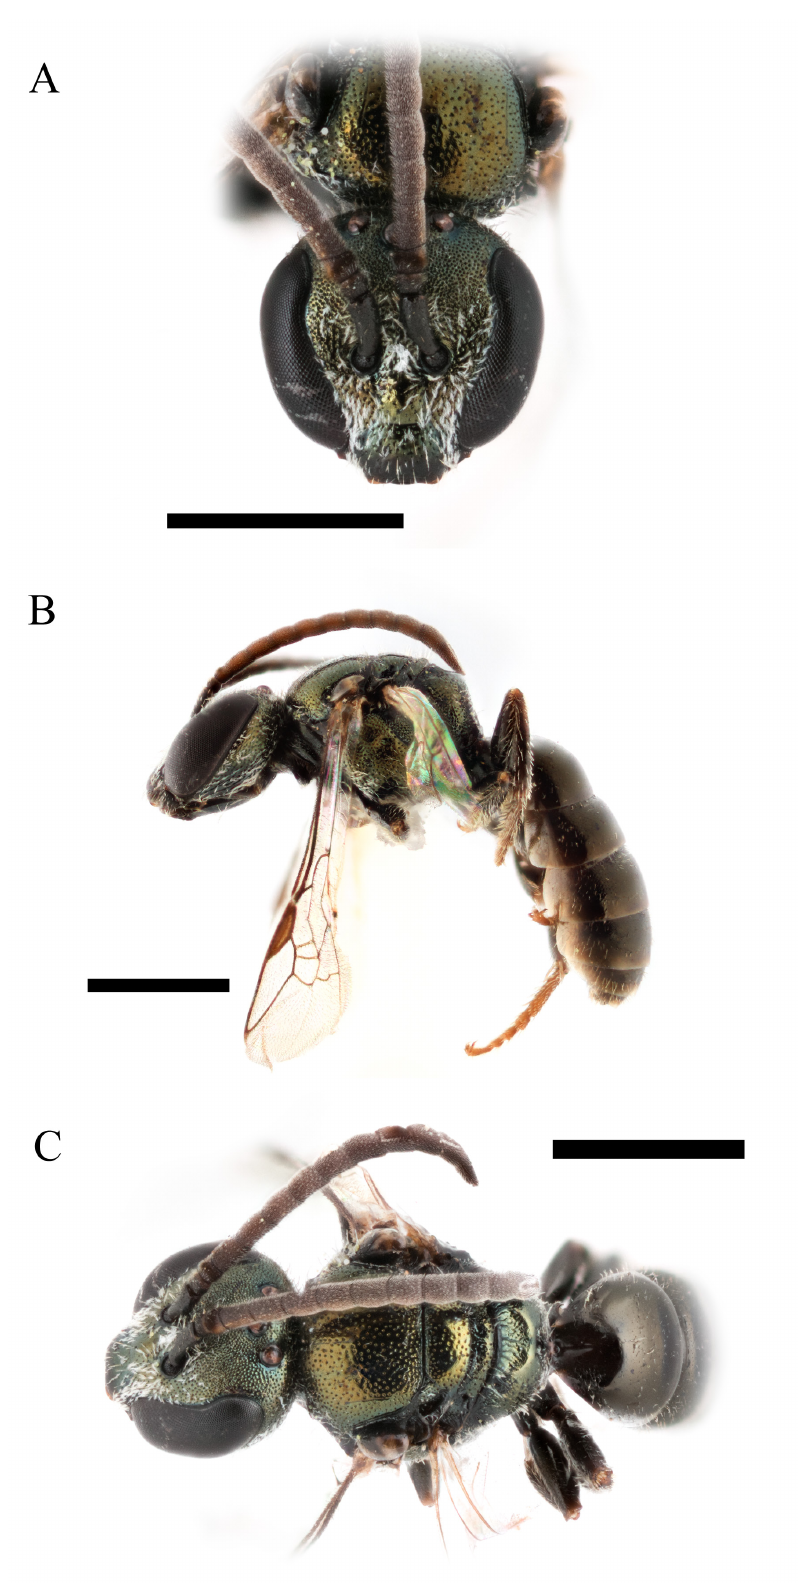
Fig. 3. Lasioglossum ( Dialictus ) dominicense sp. nov. Paratype, ♂. A . Face. B . Lateral habitus. C . Dorsum of mesosoma. Scale bars = 1